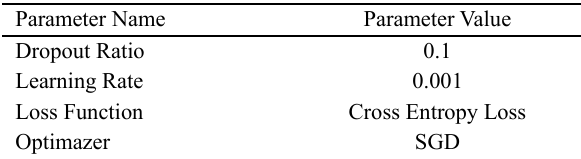
Table 1. Parameters involved in the